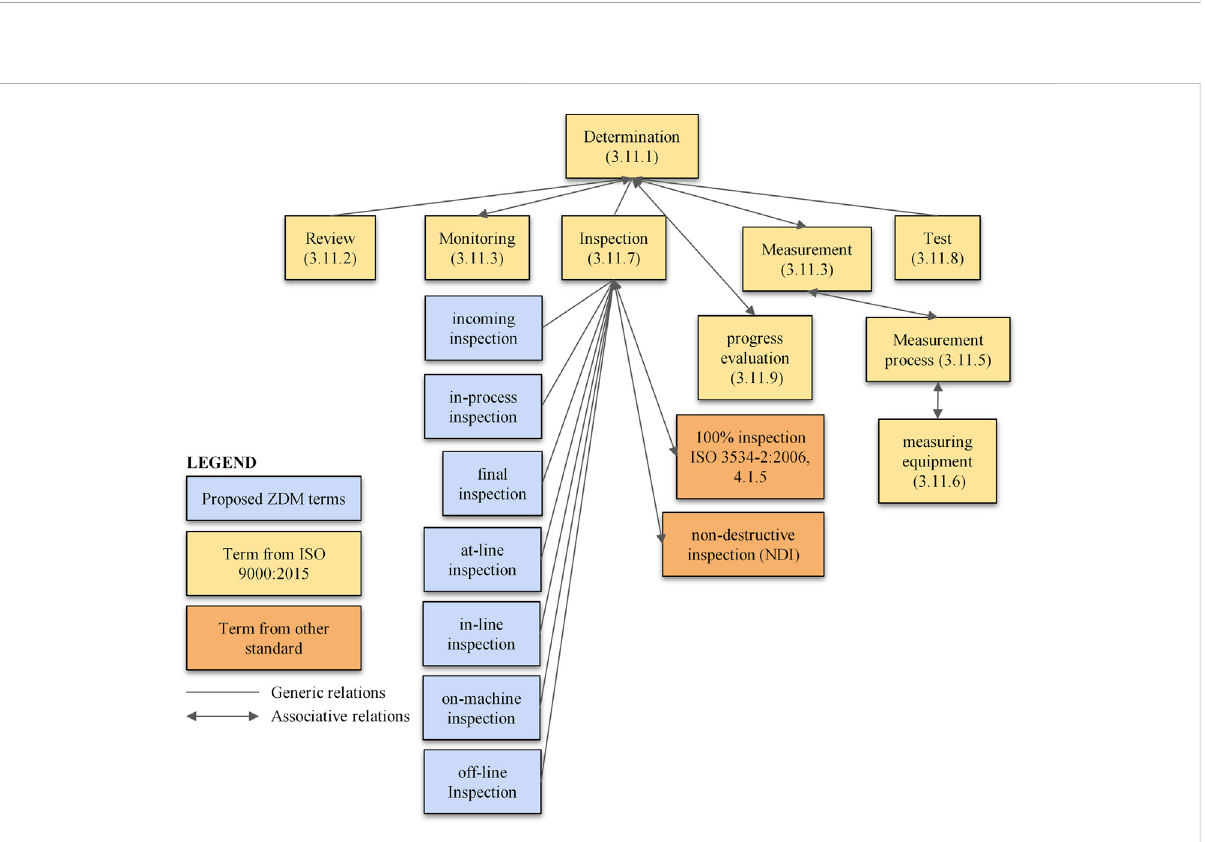
FIGURE 7 Someconceptsrelatedto inspection inISO9000:2015andrelationtoZDMterms[adaptedfrom(ISO,2015b)].TermscollectedfromISO9000: 2015 and other standards include the entry number in that standard for better reference and